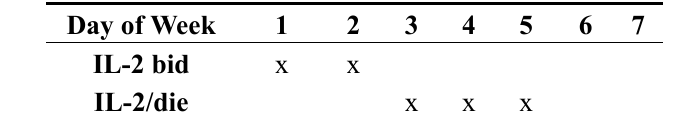
Table 1. Schedule of IL-2 treatment repeated for 4 consecutive weeks with a 4-week rest period until progression of the disease or intolerable